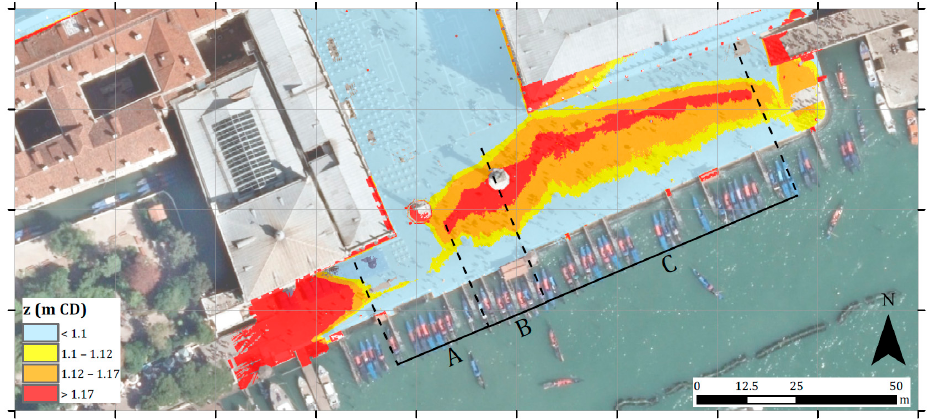
Figure 2. Location and orthophoto of the study site: Piazza S. Marco, Venice, Italy. Table 1. Summary of the cross-section types that characterize the Riva S.